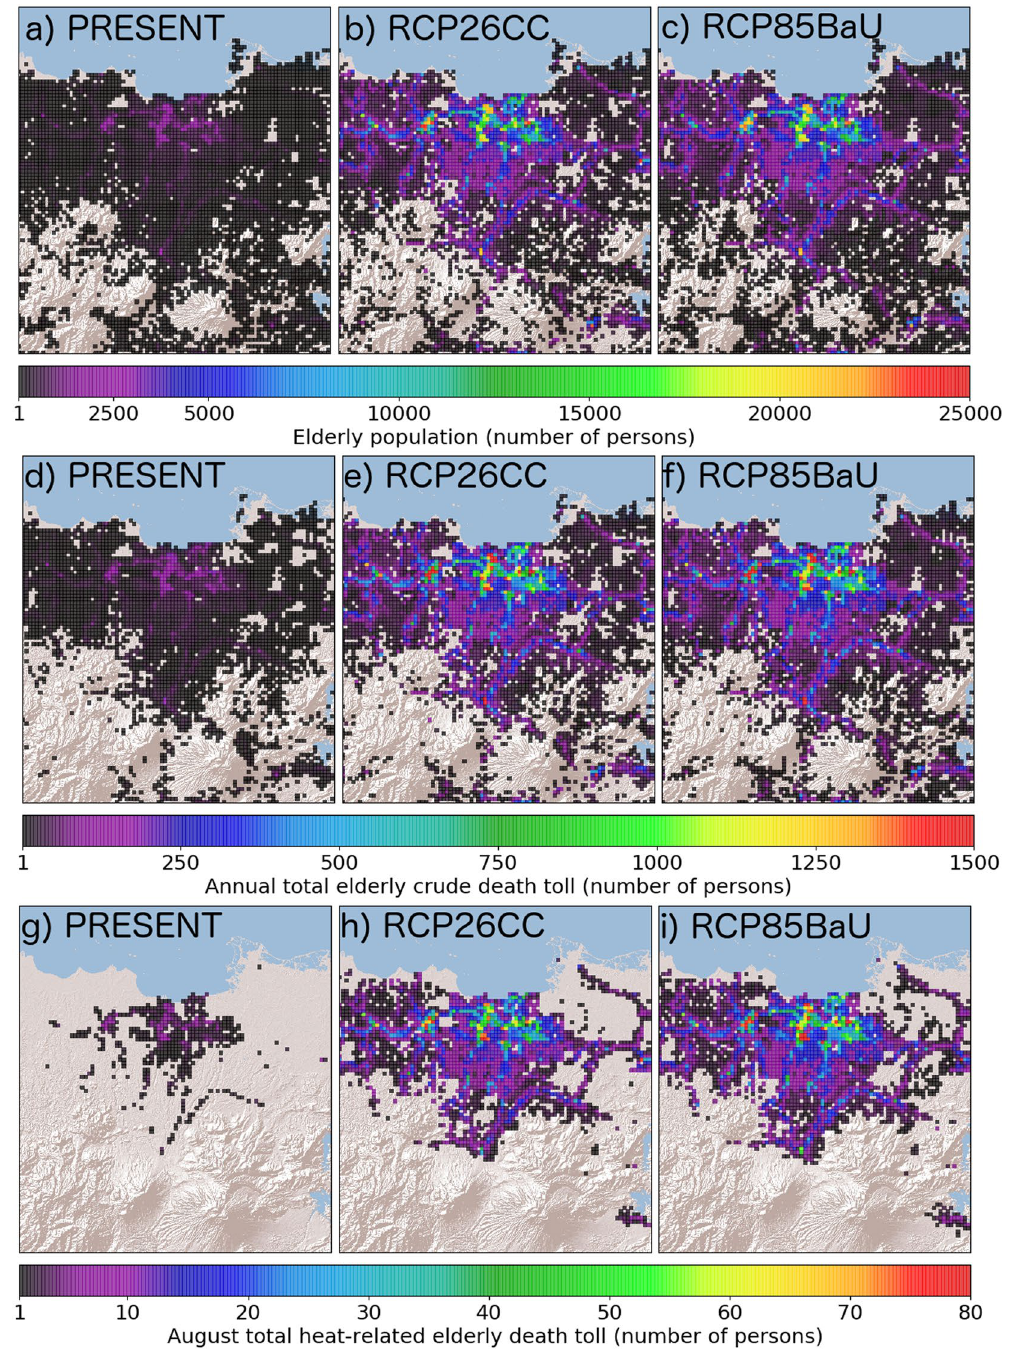
Figure 1. ( a–c ) correspond to estimated elderly population per grid for PRESENT, RCP26CC, RCP85BaU, respectively. ( d , e ), f represent annual total elderly mortality count per grid for PRESENT, RCP26CC, RCP86BaU, respectively. ( g–i ) show August total heat-related elderly mortality count per grid for PRESENT, RCP26CC, RCP86BaU,